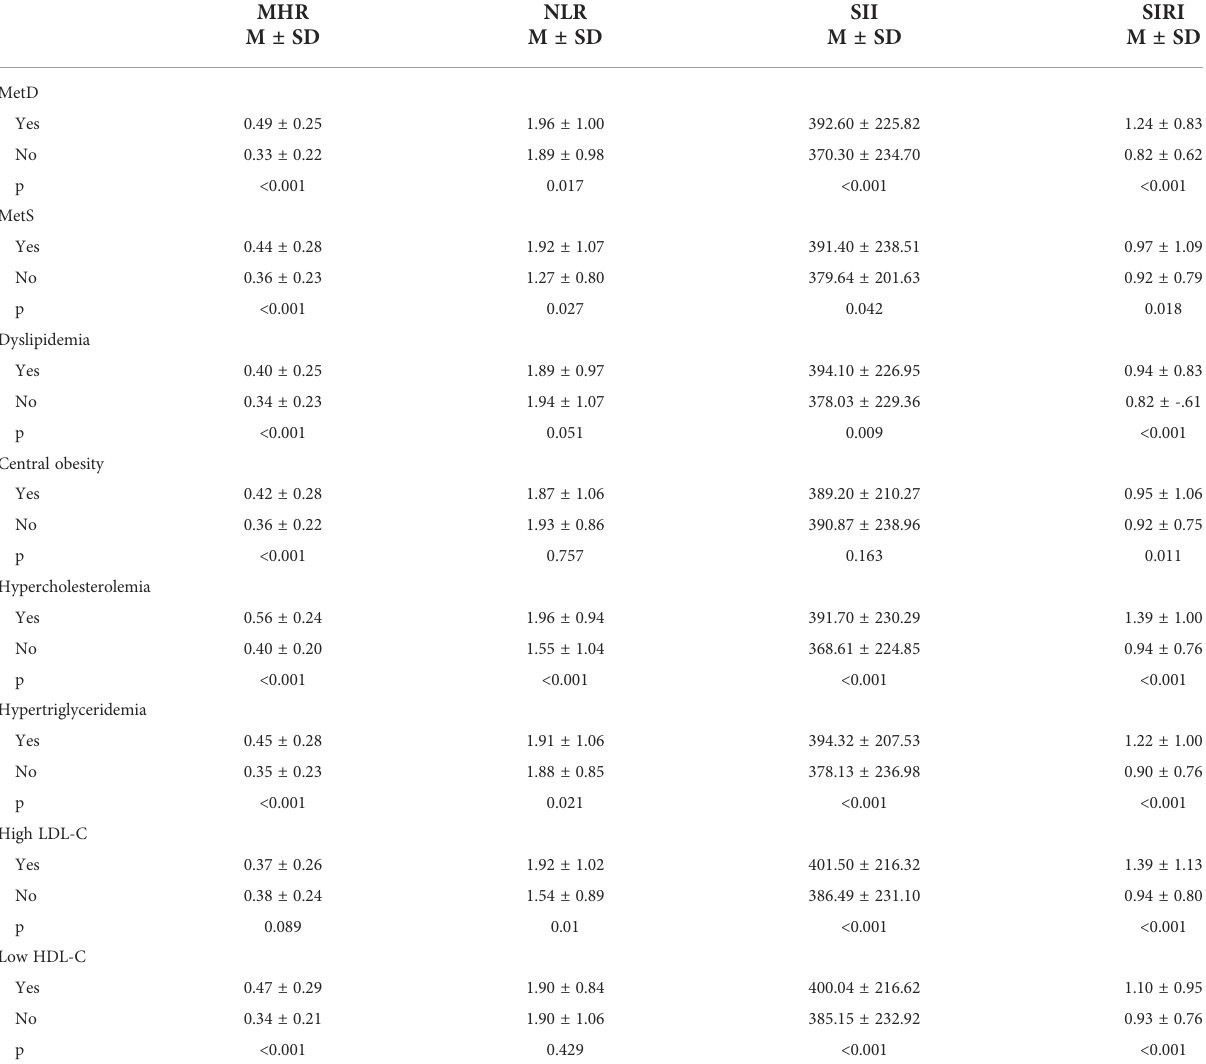
TABLE 3 The different levels of in fl ammation parameters divided by metabolic disorders or their